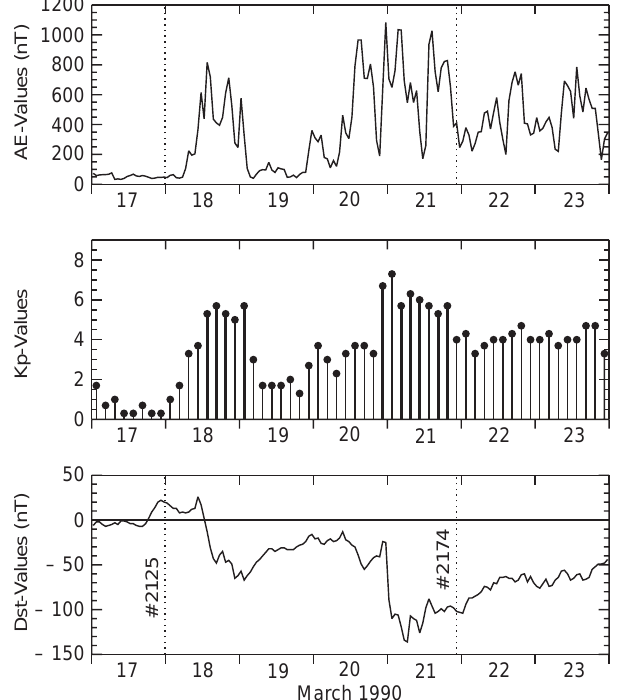
Fig. 1. Time variations of the geophysical indices AE, Kp, and Dst during the CEDAR storm of March 1990. The precise time of the Active overflights are indicated by dashed vertical